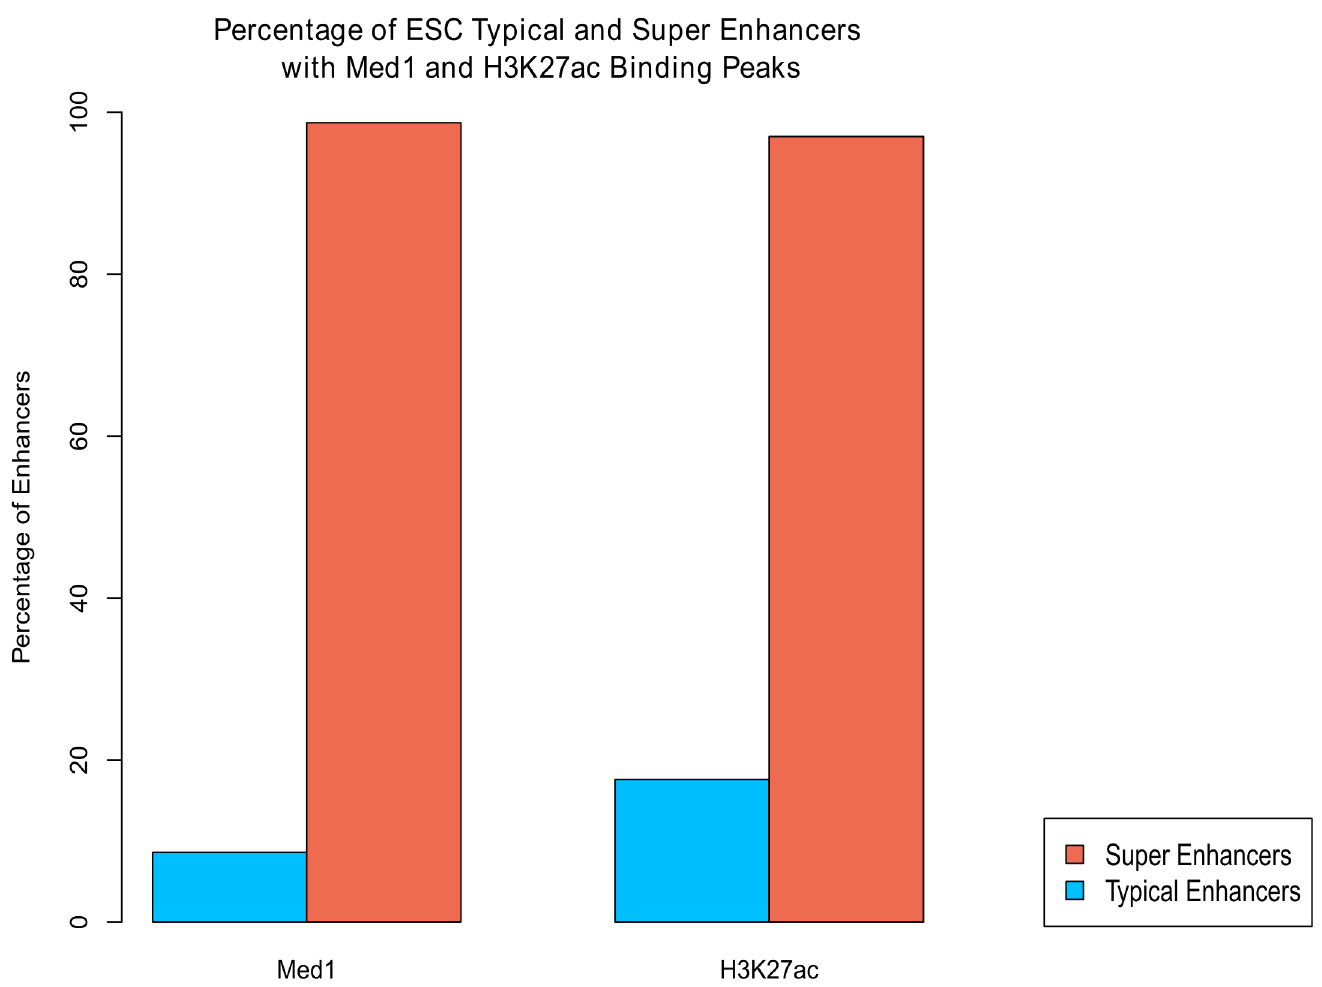
Fig 4. Comparison of Mediator (Med1) and H3K27ac occupancy in Super Enhancers and Typical Enhancers. PAPST quickly identified that significantly more SEs are occupied by Med1 and H3K27Ac than TEs. Quickly answering questions of this nature make PAPST ideal for exploratory